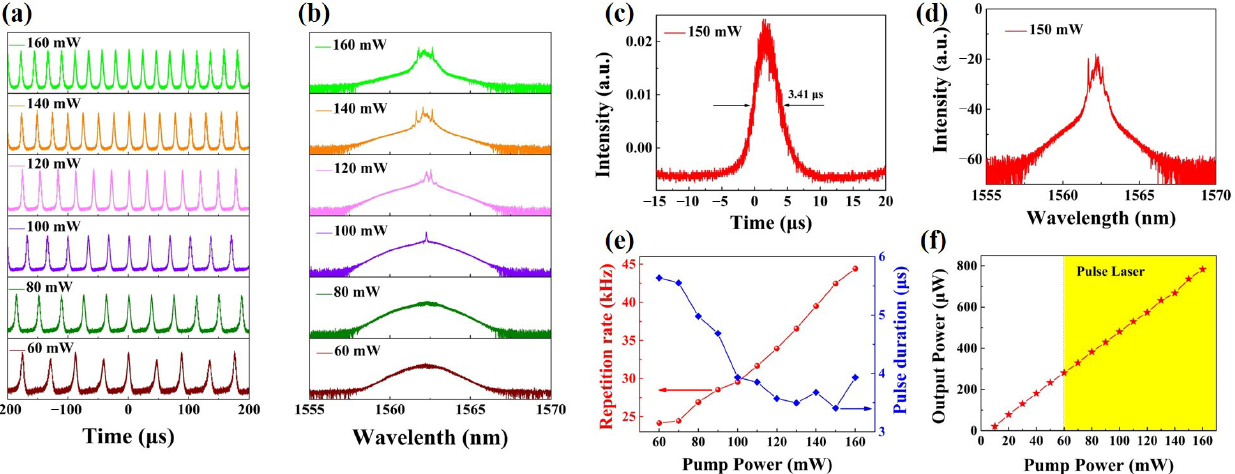
Figure 5. ( a ) pulse sequences. ( b ) the output spectra at given different pump powers. ( c ) the single pulse width at 150 mW pump power. ( d ) the output spectrum of the output pulse at 150 mW pump power. ( e ) repetition frequency and pulse duration as a function of pump power, and ( f ) the relationship between the average output powers and pump powers.